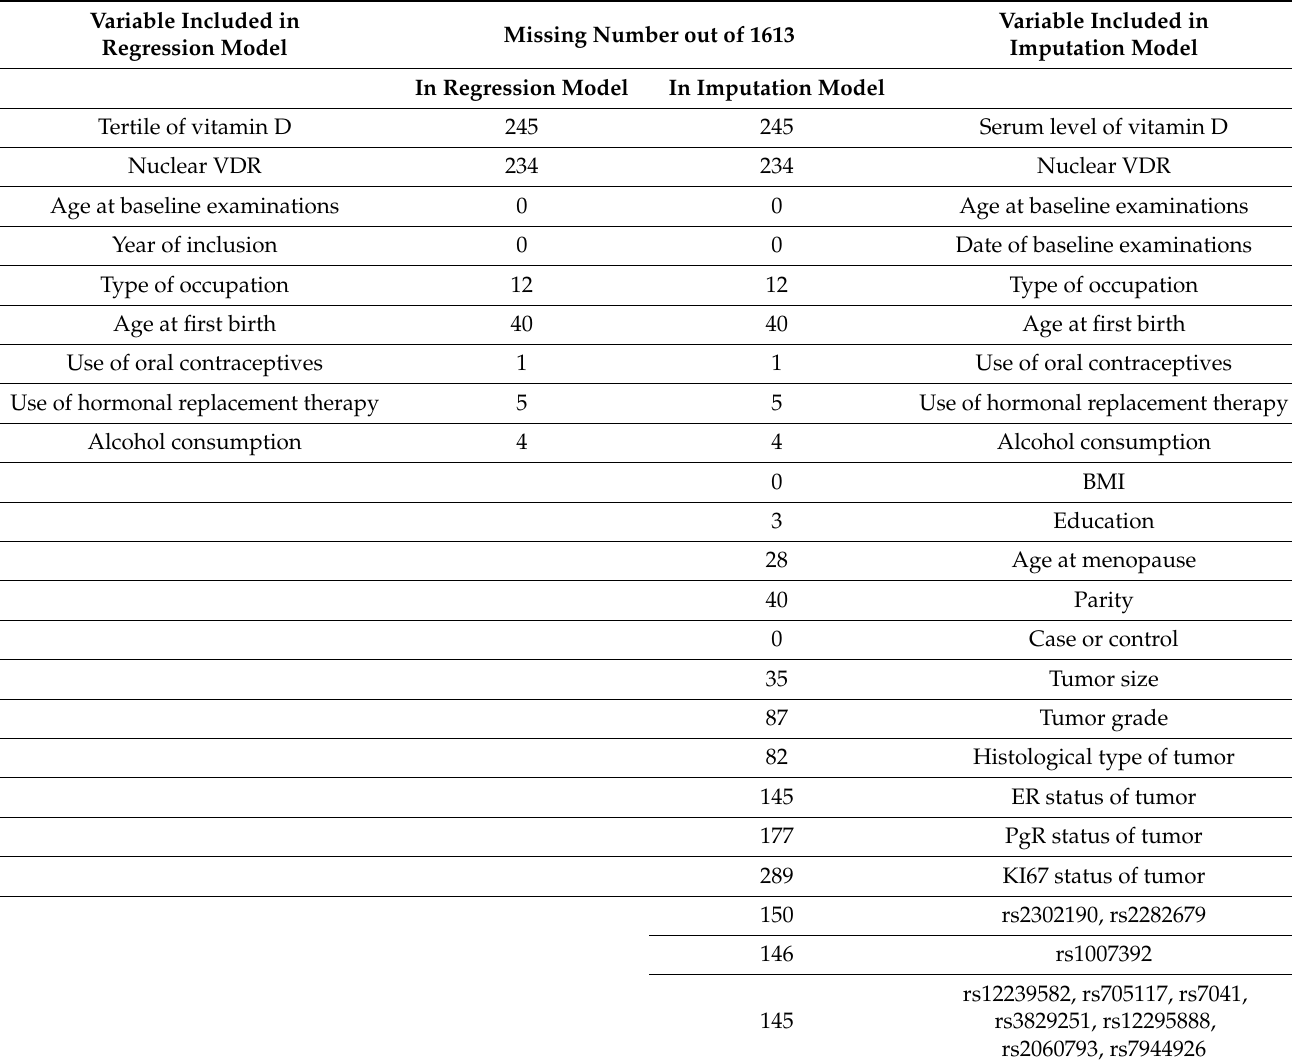
Table A1. Imputation Model 1: Used for Binary Logistic Regression Presented in Table